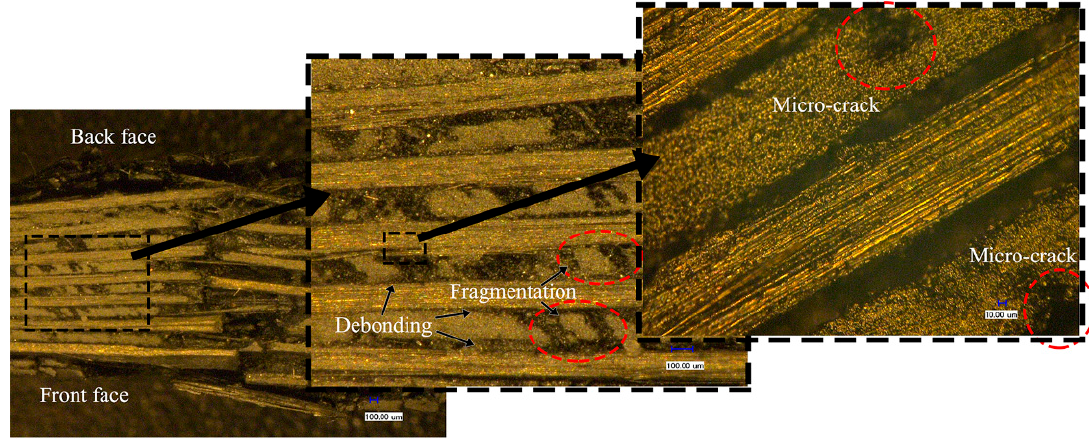
Figure 13. Impact-damaged images of the dry specimen subjected to the impact velocity of 45 m/s using the 3D-SDDM technique. Materials 2018 , 11 , x FOR PEER REVIEW